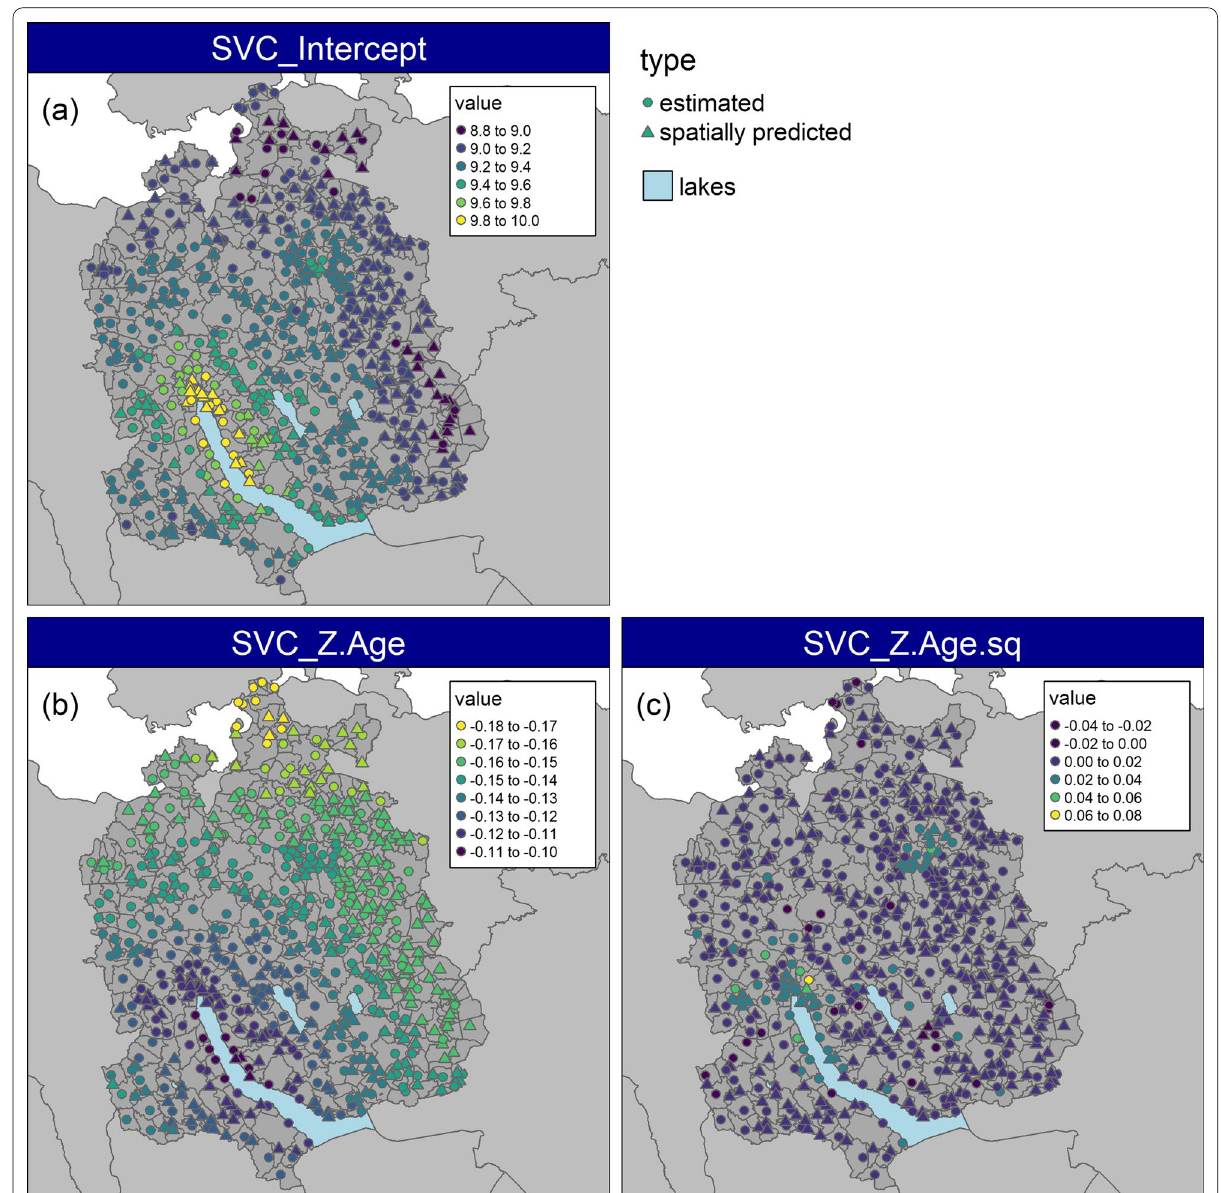
descending from ( a ) to ( c